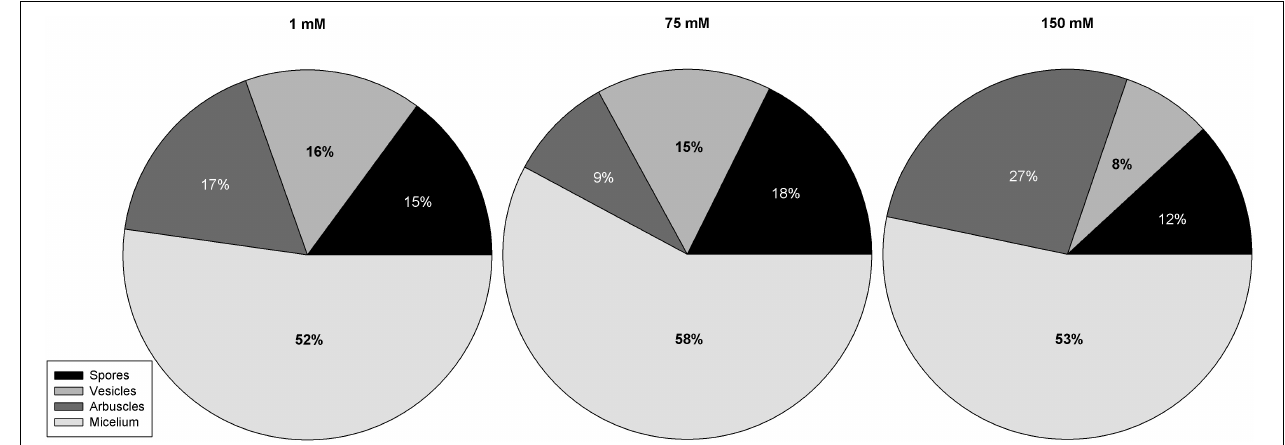
FIGURE 1 | AM fungi structures percentages to the total colonization of each salinity